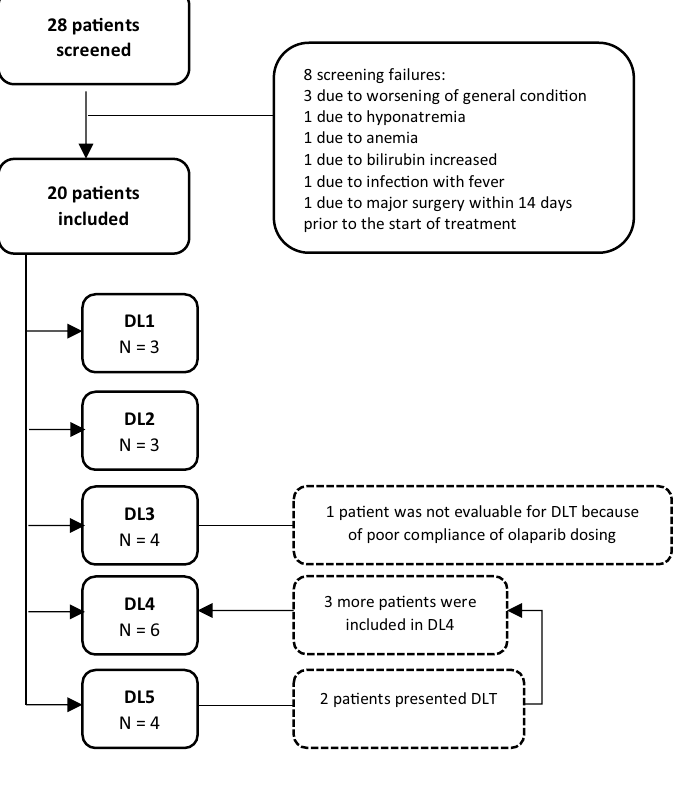
Figure 2. Consort